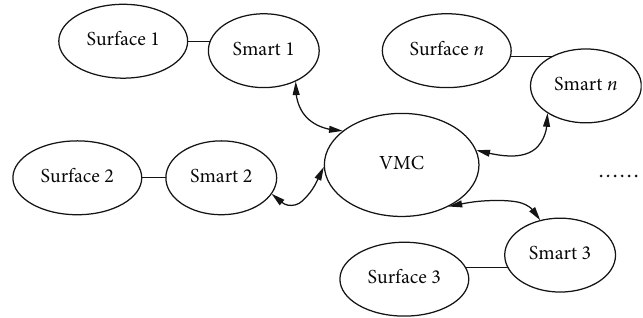
Figure 1: Distributed fl ight control system architecture.